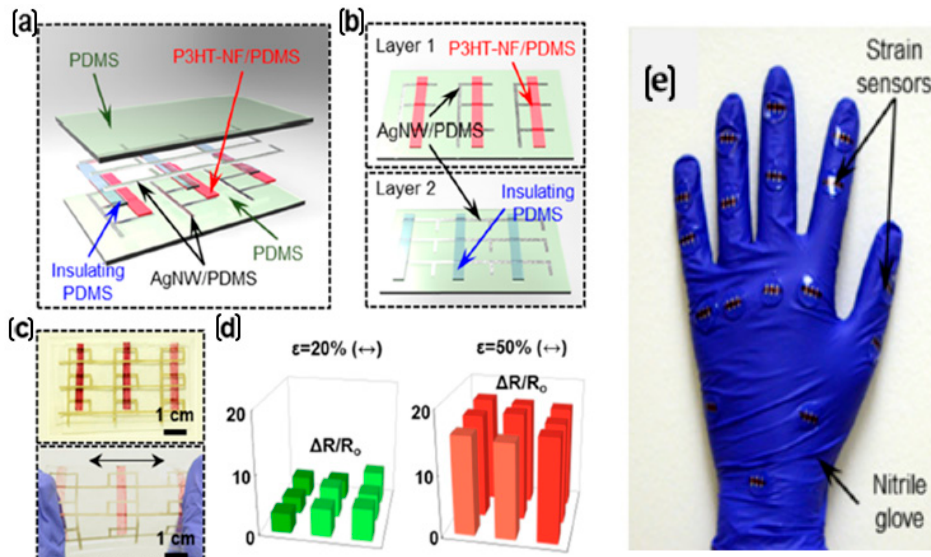
Figure 10. ( a ) A 3 × 3 strain sensor array. ( b ) Schematic of layers 1 and 2. ( c ) The array in the normal state (upper) and stretched state (lower). ( d ) The Δ R/R0 of the array upon 20% and 50% mechanical strain. ( e ) Strain sensors placed on a hand glove for gesture recognition. Reprinted with permission from Ref. [99]. Copyright 2018, American Chemical Society.